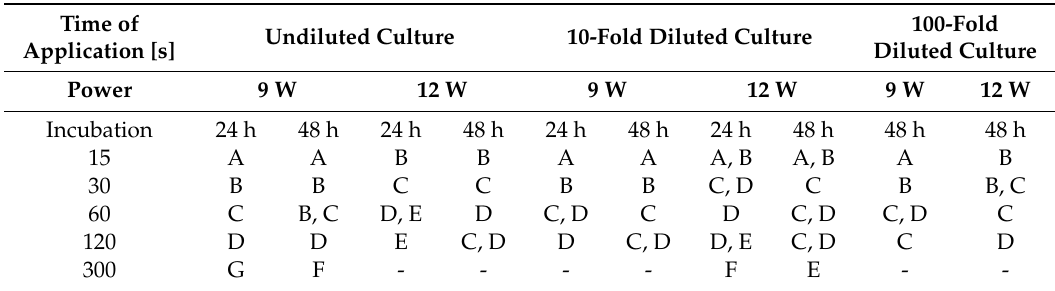
Table 1. Statistical analysis of results evaluating inhibition zone sizes; points with different letter(s) A−F are statistically different ( p < 0.05) according to the mean ± SD (n = 6). Time of Application